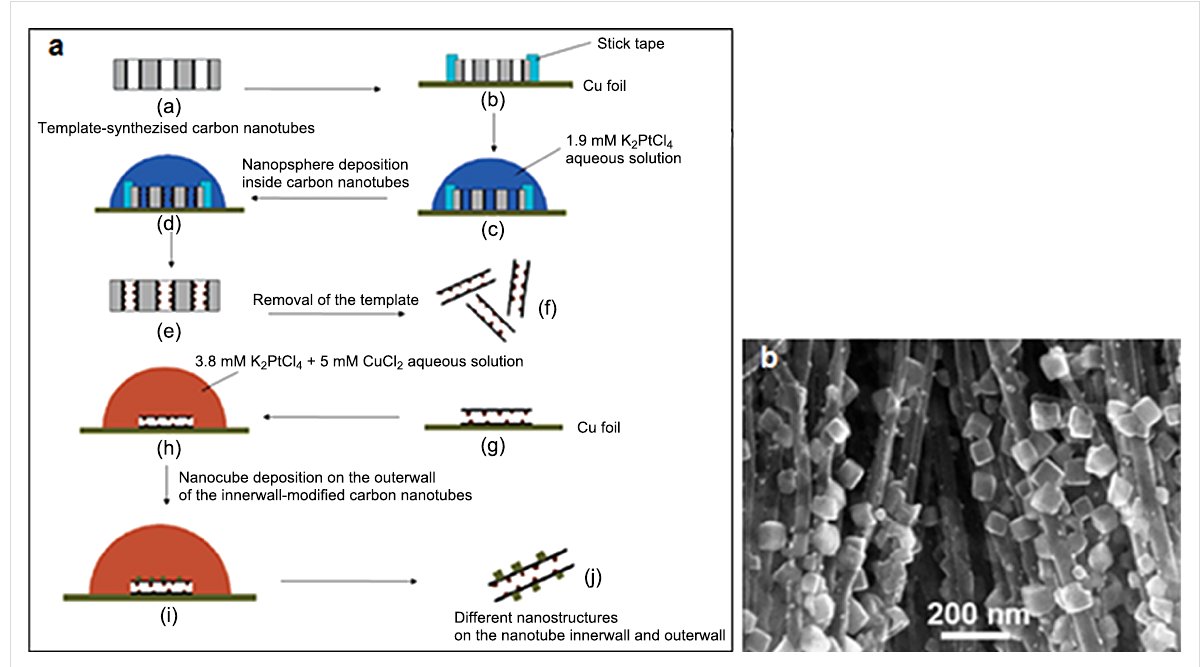
Figure 13: (a) Procedures for the nanotube inner wall modification and the asymmetric modification of the nanotube inner wall with Pt nanospheres and the outer wall with nanocubes. For the sake of clarity, only a few of the many CNTs on the Cu foil are shown. (b) SEM image of aligned CNTs decorated with Pt nanocubes. Adapted with permission from [119]. Copyright 2006 American Chemical